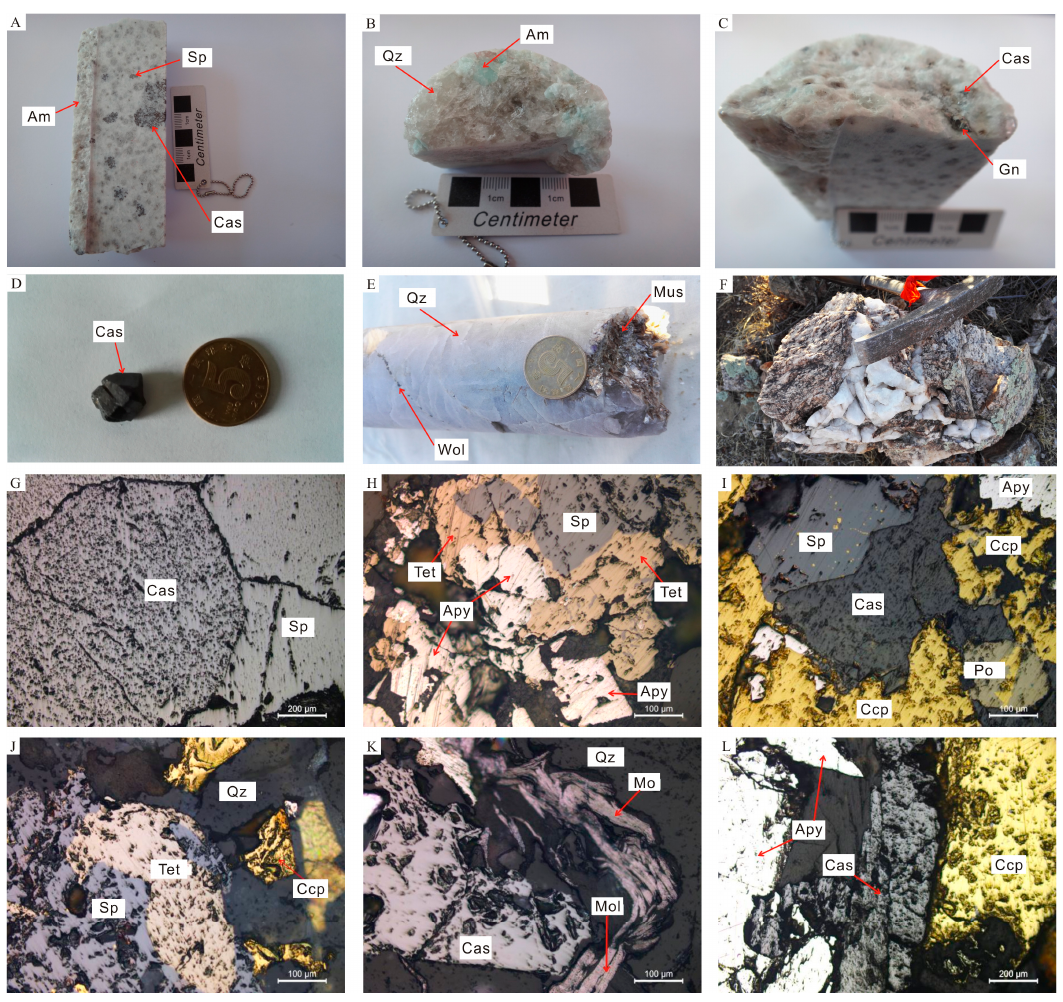
Figure 4. Photographs of mineralization features in the Weilasituo Sn-polymetallic deposit: ( A ) Disseminated cassiterite and sphalerite in quartz porphyry; ( B ) Amazonite in the quartz porphyry; ( C ) Cassiterite and galena in the quartz porphyry; ( D ) Euhedral cassiterite; ( E ) Typical greisen with wolframite; ( F ) Breccia collected from the surface; ( G ) Cassiterite and sphalerite intergrowths; ( H ) Sphalerite, arsenopyrite and tetrahedrite; ( I ) Cassiterite, sphaletire, arsenopyrite, pyrrhotite and chalcopyrite; ( J ) Greisen vein with sphaletire, tetrahedrite and chalcopyrite; ( K ) Greisen vein with molybdenite and cassiterite; ( L ) Greisen vein with cassiterite, arsenopyrite and chalcopyrite.